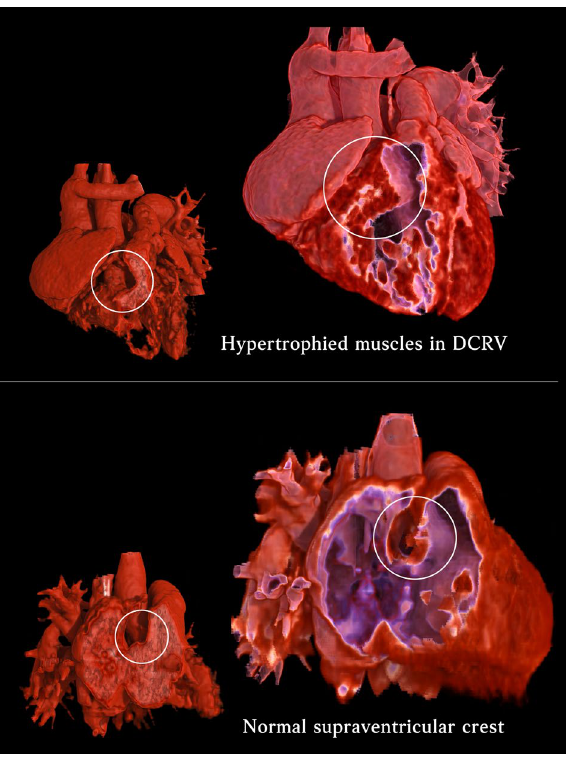
Figure 5. Myocardial models demonstrate muscular thickness and morphology in detail, enabling us to differentiate a normal supraventricular crest (lower row), which is supposed to be just a hollow infolding of the RV wall, from a “solid” hypertrophied muscular ridge in DCRV (upper row). Whereas with regular luminal volume rendering (smaller pictures in the lower left), the models simply outline areas with contrast filling. We see a protrusion into the right ventricle in both normal (lower left in lower row) and DCRV (lower left in upper row) patients, but we are unable to evaluate whether it is caused by solid hypertrophied muscles or just a hollow infolding. All models were frozen at the end-systolic